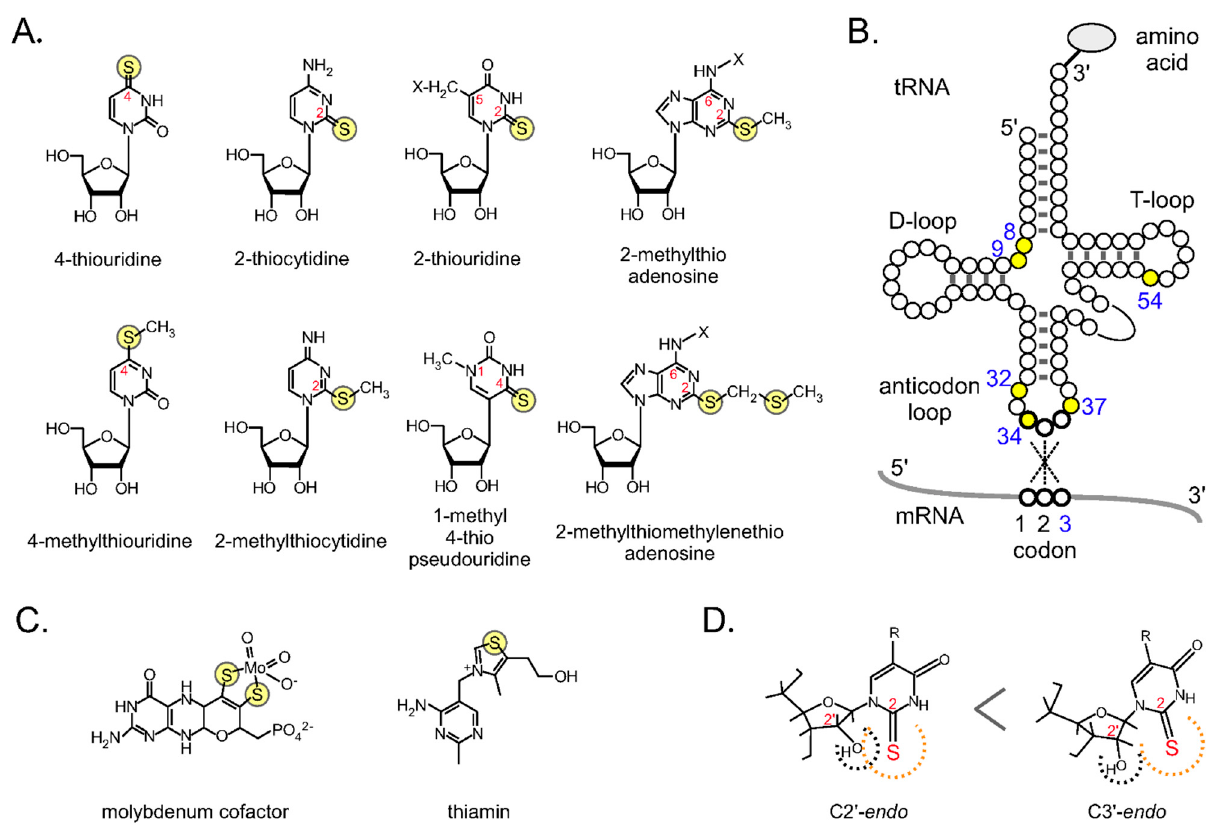
Figure 1. Sulfur-containing tRNA modifications: ( A ) Chemical structures of thiolated nucleosides. ( B ) Secondary structure of tRNA and the positions of thiolated nucleosides in tRNA. The codon triplet (codon positions 1, 2, and 3) base pairs with positions 36, 35, and 34, respectively, in the anticodon of the tRNA. ( C ) Examples of sulfur-containing cofactors. ( D ) Conformation of xm 5 s 2 U. Due to the steric hindrance of the 2-thio and 2’-OH groups, the C3’- endo form is preferred. This figure was modified from Figure 1 in [3].